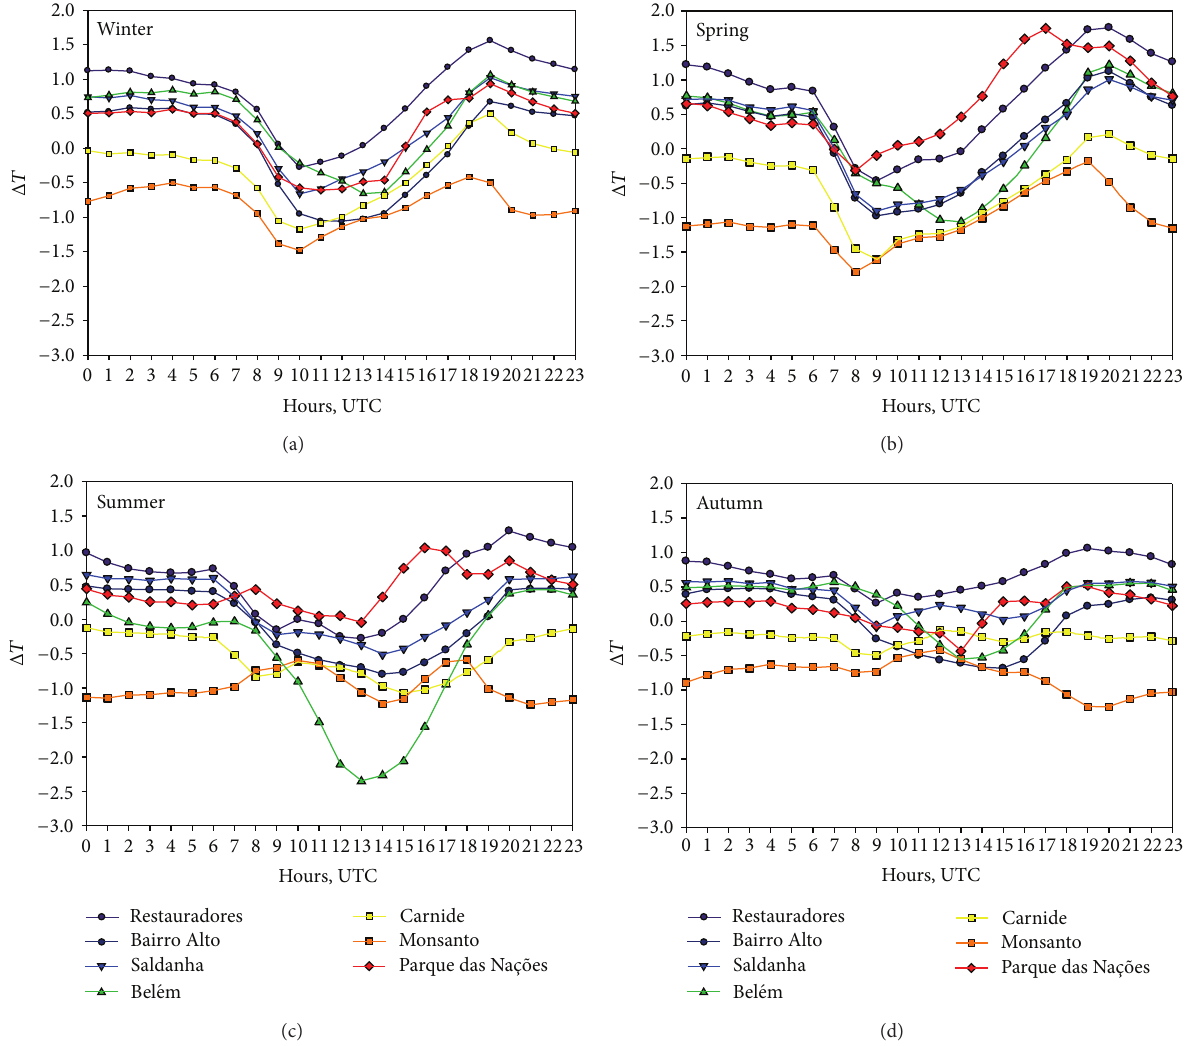
Figure 5: Seasonal hourly average deviations between the urban sites of the CEG/CliMA mesoscale network and Lisbon Airport. Winter: DJF; Spring: MAM; Summer: JJA; Autumn